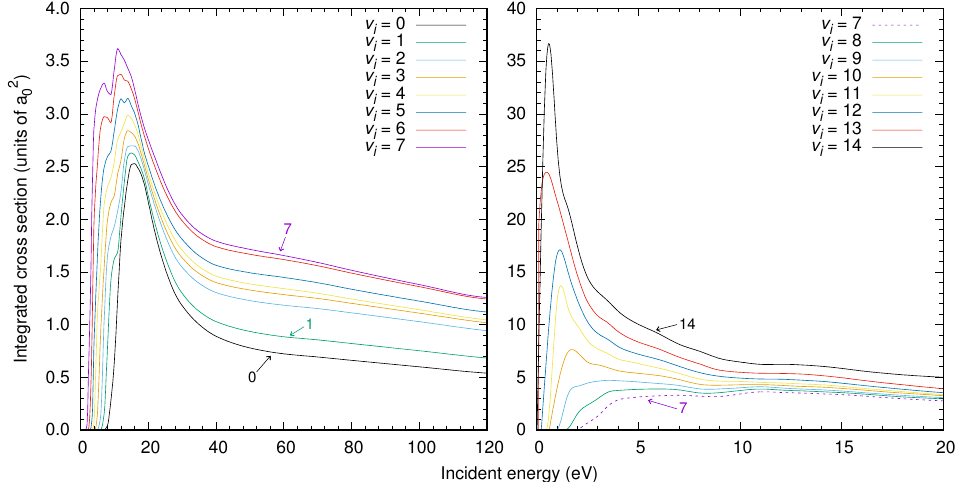
Figure 5. Electron-impact dissociation cross section for scattering on all bound vibrational levels of the H 2 ground electronic state. The cross sections rise monotonically with increasing vibrational level v i .